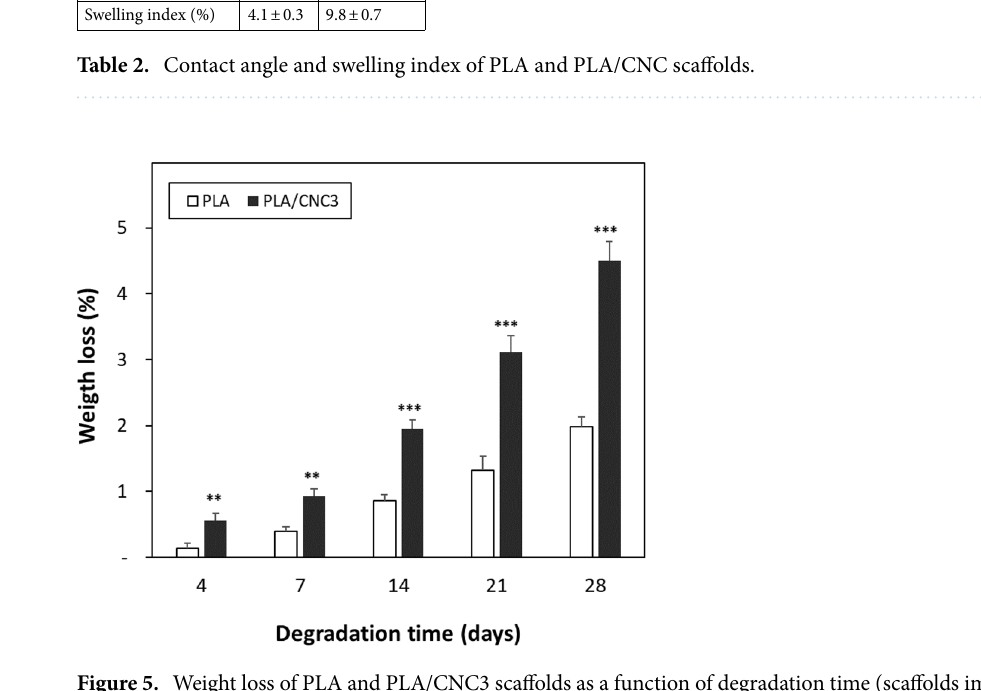
Figure 5. Weight loss of PLA and PLA/CNC3 scaffolds as a function of degradation time (scaffolds immersed in alcalase buffer over a period of 28 days). (** p ˂ 0.01 and *** p ˂ 0.001 using an unpaired-t-test